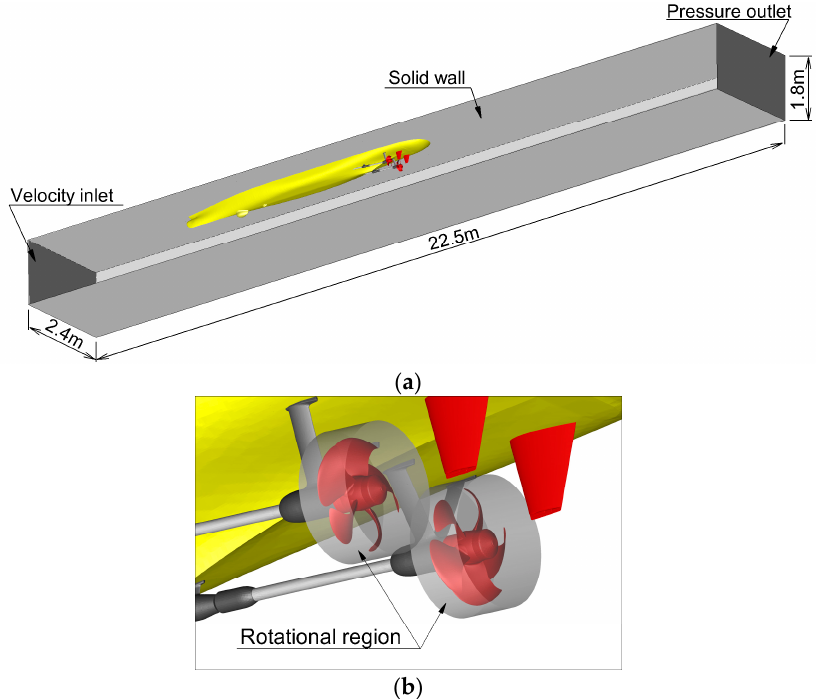
Figure 2. Computational domain: ( a ) computational domain of the ship model and boundary conditions; ( b ) starboard and port rotational regions containing the propellers.